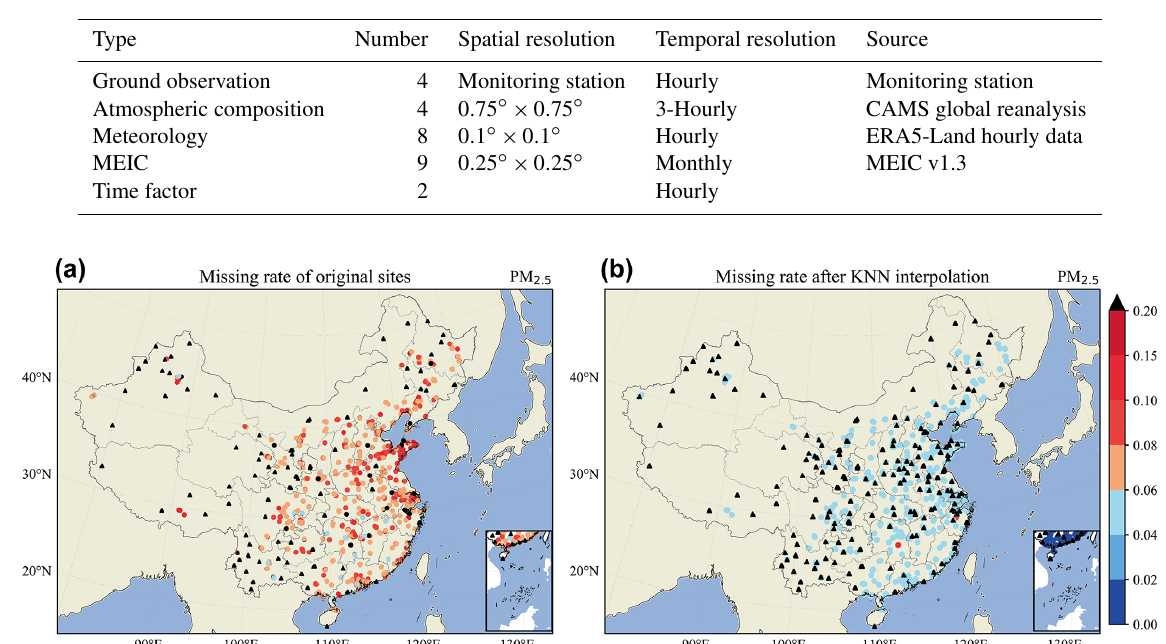
Figure 2. Missing fraction of (a) original and (b) KNN-interpolated PM 2 . 5 data. Dots and triangles denote the locations of air quality monitoring stations, and dot colors represent the missing data rate of each monitoring station. Black triangles indicate monitoring stations with 20% missing data or over 15% missing data after KNN interpolation that were excluded from the